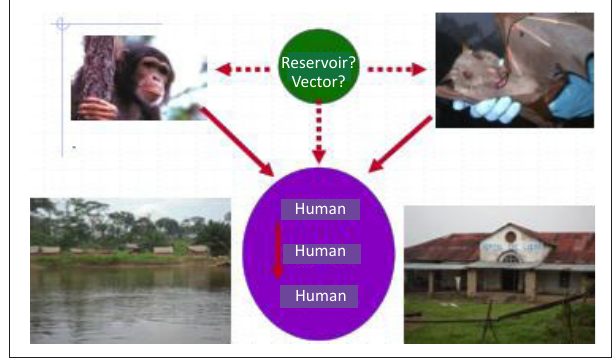
FIGURE 4: The potential chains of transmission of Ebola virus may be described as involving 3 stages, from primates or bats to humans (especially hunters) in the wild (index case), from index case to secondary cases (introduction into the domestic environment) and from patient to healthcare personnel in the clinical setting. Whilst primates and fruit bats are known to be sources of Ebola virus in nature, the reservoir has not yet been identified with any certainty.